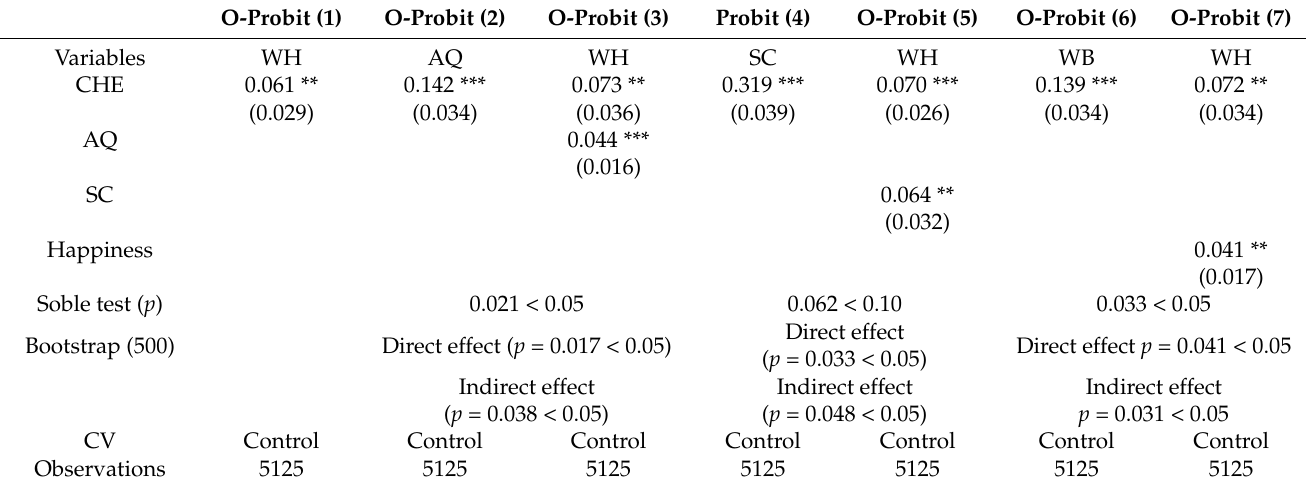
Table 6. The results of mediating effect test for CHE and WH: AQ, SC, and WB.